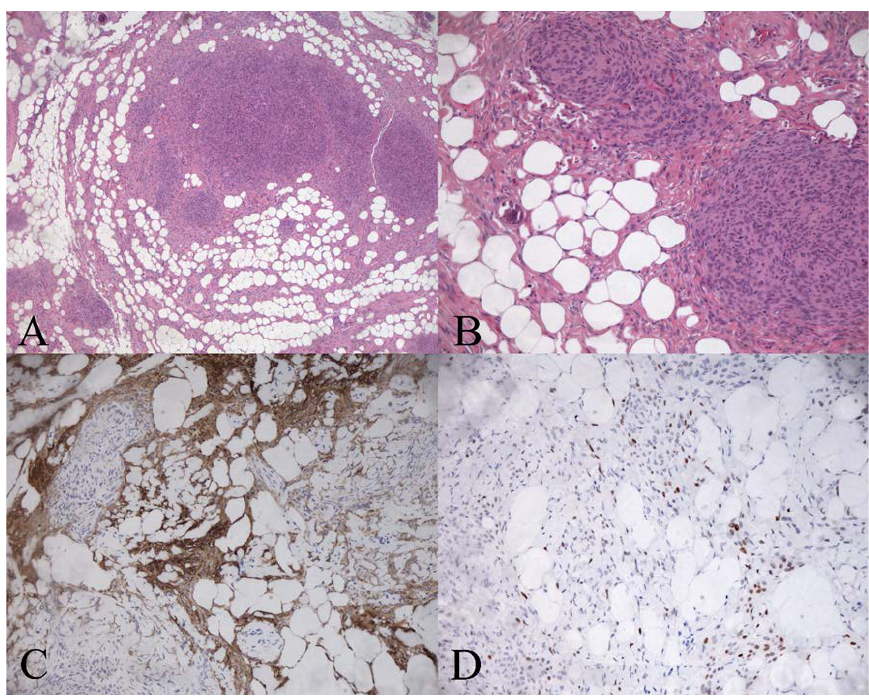
Figure 3. Histological examination. Metaplastic lipomatous meningioma; ( A ) Tumour tissue con- taining islands of typical meningothelial neoplastic cells in a field of fat-like large cells (H&E ×100). ( B ) Fat-like tumour cells have round nuclei and large fat vacuoles in the cytoplasm (H&E ×200). ( C ) Fat-like tumour cells show expression of Epithelial Membrane Antigen (EMA ×200). ( D ) Positive staining for Progesterone Receptor (PR, ×200). The tumour cells were positive for epithelial membrane antigen (EMA) and Proges- terone Receptor (PgR). Ki-67 was <2%. The patient’s recovery and postoperative course were uneventful. MRI images at a nine-month follow-up show no sign of residual or re- current disease (Figure 4).